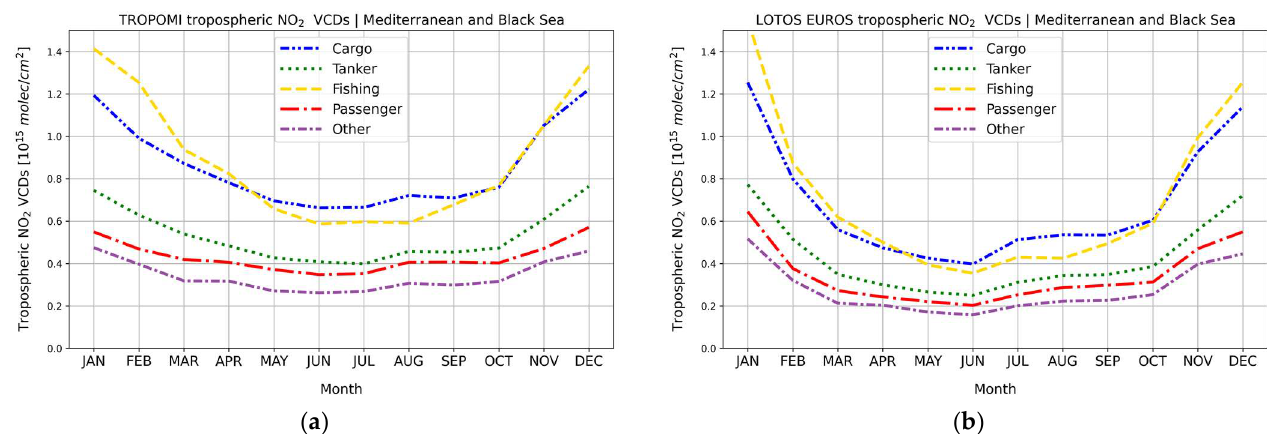
Figure 9. Tropospheric NO 2 vertical column densities (in 10 15 molecules cm −2 ) seasonal variability according to the 2019 vessel density for the Mediterranean and Black Sea regions: ( a ) TROPOMI; ( b ) LOTOS-EUROS.